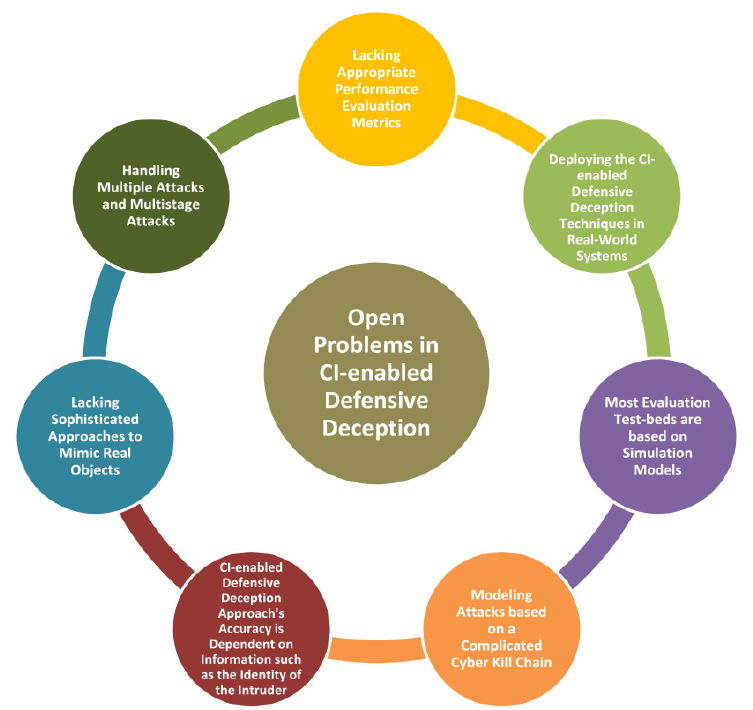
Figure 5. Open Problems in CI-enabled Defensive Deception.